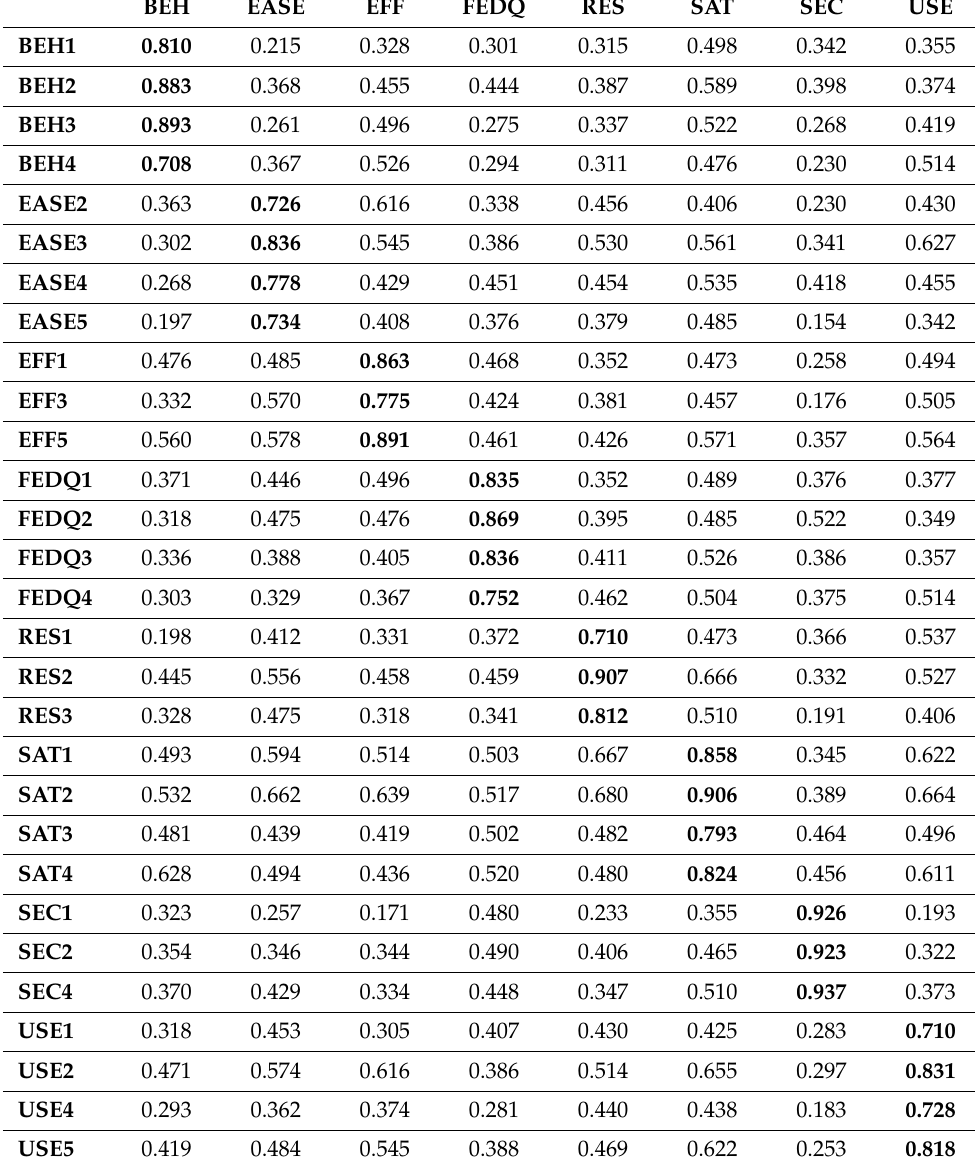
Table 1. Standardized factor loadings and cross-loadings of